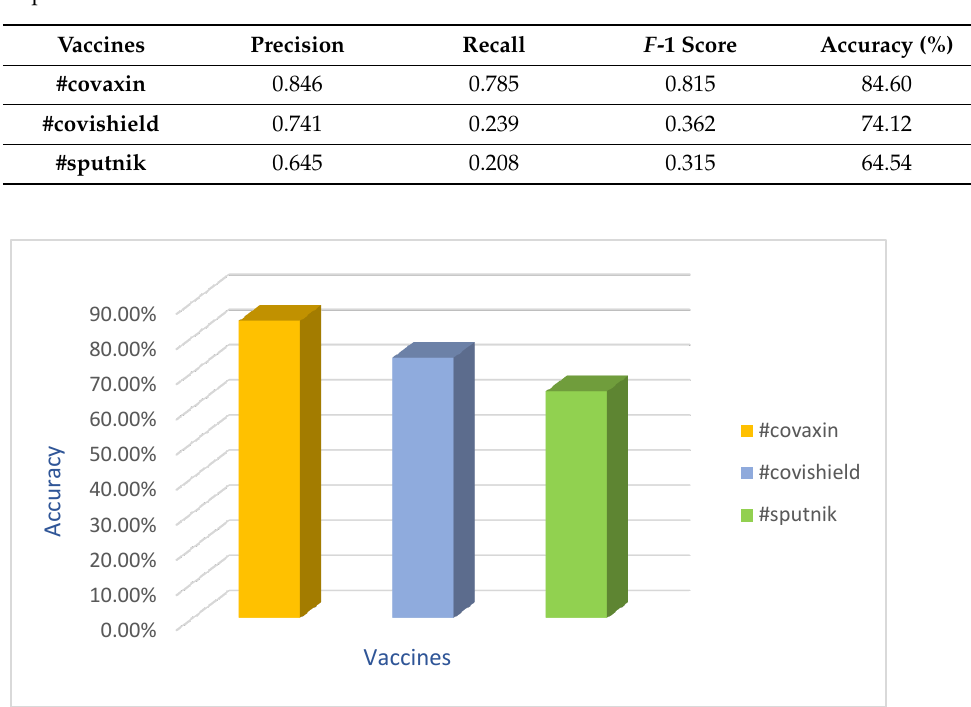
Figure 10. Comparison of the accuracy percentages for #covaxin, #covishield, and #sputnik.